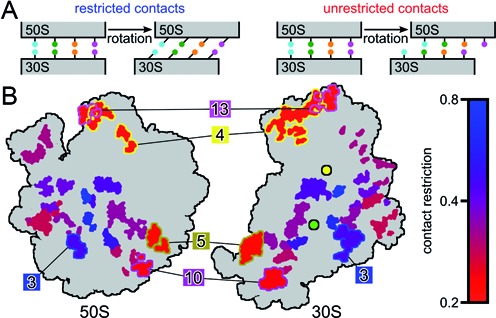
Changes of intersubunit contacts during translocation. (A) Schematic of two mechanisms to maintain intersubunit interaction despite rotation. (B) The contact restriction is color-coded for each intersubunit contact cluster. Clusters 3, 4, 5, 10 and 13 are highlighted. Pivot points are indicated for head (yellow circle) and body rotation (green circle), pivot point positions taken from Bock et al. (25).